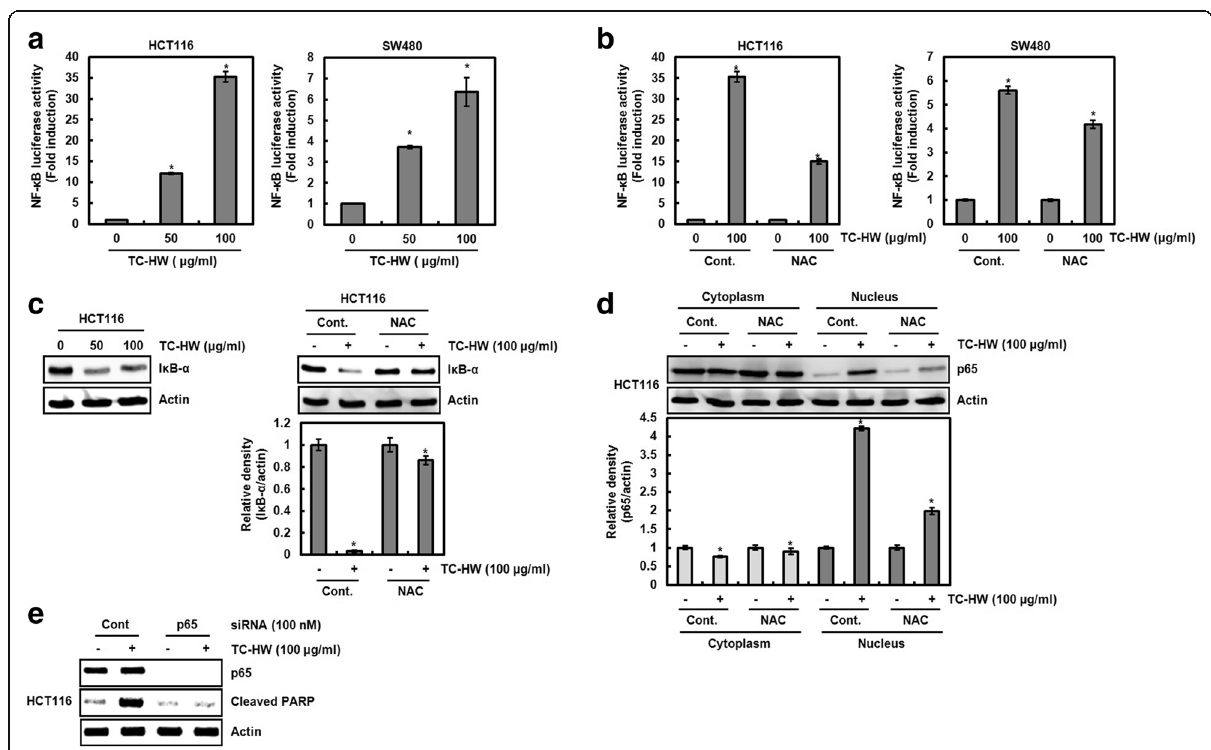
Fig. 5 Contribution of ROS-dependent NF- κ B activation to TC-HW-mediated apoptosis. a and b HCT116 and SW480 were co-transfected with NF- κ B luciferase construct and pRL-null. The cells were treated with TC-HW in presence/absence of NAC. Luciferase activity for NF- κ B was measured as a ratio of firefly luciferase signal/renilla luciferase signal using a dual luciferase assay kit. * P < 0.05 compared to cell without TC-HW. c HCT116 cells were treated with TC-HW (100 μ g/ml) in presence/absence of NAC. Cell lysates were subjected to SDS-PAGE and the Western blot was performed using antibody against I κ B- α . Actin was used as internal control for Western blot analysis. * P <0.05 compared to cell without TC-HW. d HCT116 cells were treated with TC-HW (100 μ g/ml) in presence/absence of NAC. Cytosol and nucleus extracts were prepared and subsequently Western blot analysis